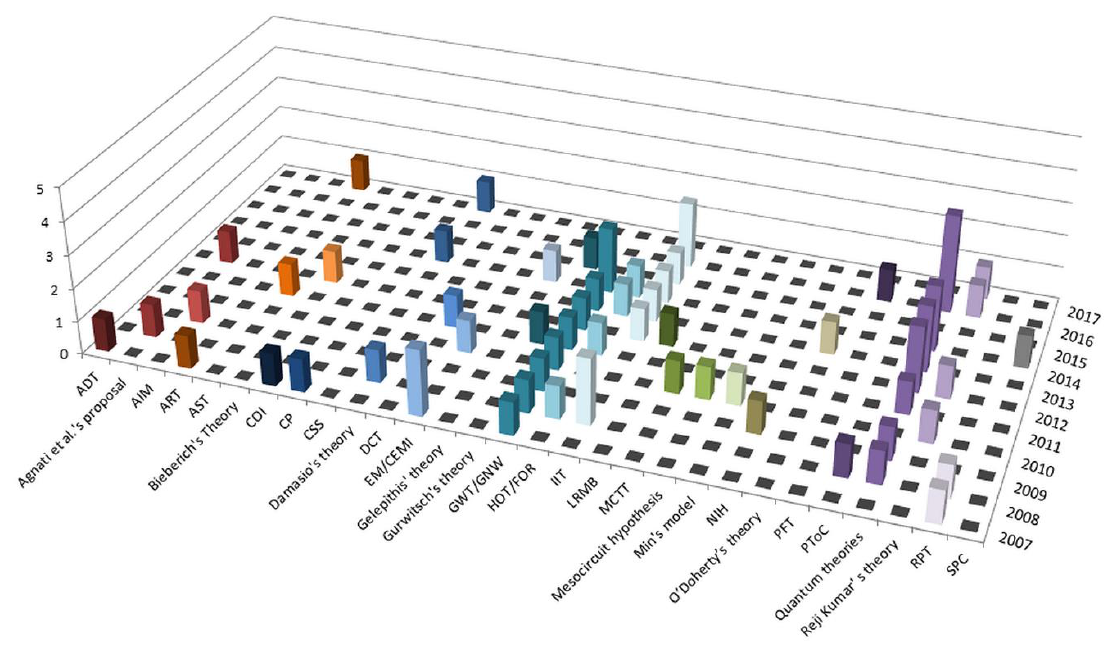
Figure 2. Graphic representation of the number of articles found for each theory in the period analyzed. ADT: apical dendrite theory; AIM: activation/information/mode-synthesis hypothesis; ART: adaptive resonance theory; AST: attention schema theory; COI: cross-order integration theory of consciousness; CP: centrencephalic proposal; CCS: consciousness state space model; DCT: dynamic core theory; EM/CEMI: electromagnetic field hypothesis/consciousness electromagnetic Information field theory; GWT: global workspace theory; GNW: global neural workspace; HOT/FOR: higher order theories of consciousness/first order representational theory; IIT: integrated information theory; LRMB: layered reference model of the brain; MCTT: memory consciousness and temporality theory; NIH: network inhibition hypothesis; PFT: passive frame theory; PToC: psychological theory of consciousness. Q theories—Orch OR: orchestrated objective reduction theory; single particle consciousness hypothesis; quantum no-go theorems; the three layer model; Koehler’s mathematical approach; timeless and spaceless; the four-dimensional Einstein; RPT: radical plasticity thesis; SPC: semantic pointer competition theory of consciousness; Agnati et al.; Bieberich’s; Damasio; Gelepithis’s; Gurwitsch’s; Min’s; O’Doherty’s; Rejikumar’s. The Mesocircuit hypothesis is not abbreviated.